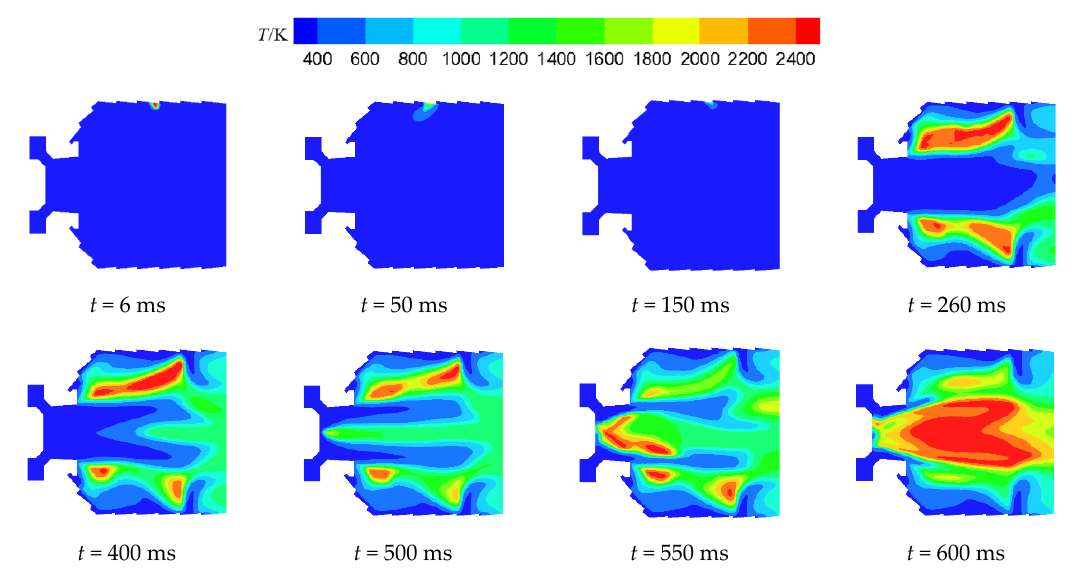
Figure 7. Numerical temperature field of combustor profile.